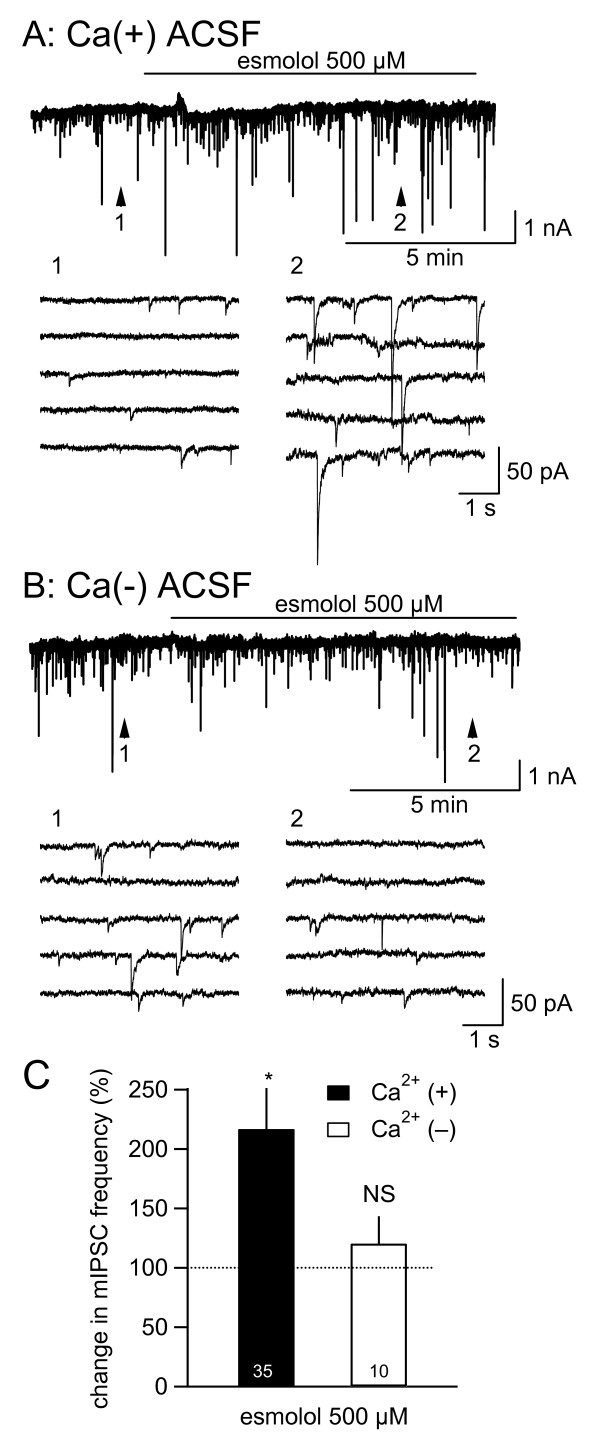
The increase in miniature inhibitory postsynaptic current (mIPSC) frequency by esmolol was dependent on extracellular Ca2+. (A and B) Top: the membrane current recording of a neuron of the caudal part of the spinal trigeminal nucleus in the presence (A) and in the absence (B) of extracellular Ca2+. Esmolol (500 μM) was applied at the horizontal bars. Recordings with "CsCl-based" internal solution. Bottom of A and B: time-expanded continuous traces taken at points 1 and 2 indicated in the top traces showing the control and the peak effects of drugs. (C) Summery of the effects of esmolol on mIPSC frequency. *, P < 0.001; Mann Whitney's U-test. NS, not significantly different; vs. pre-administration control values. The numbers in the bars indicate the number of neurons analyzed. The horizontal broken lines indicate the control values (100%).